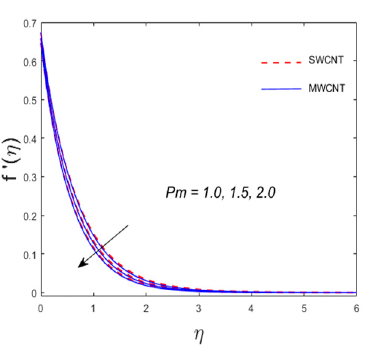
Figure 4. Outcome of Pm vs. 𝑓′(𝜂) .